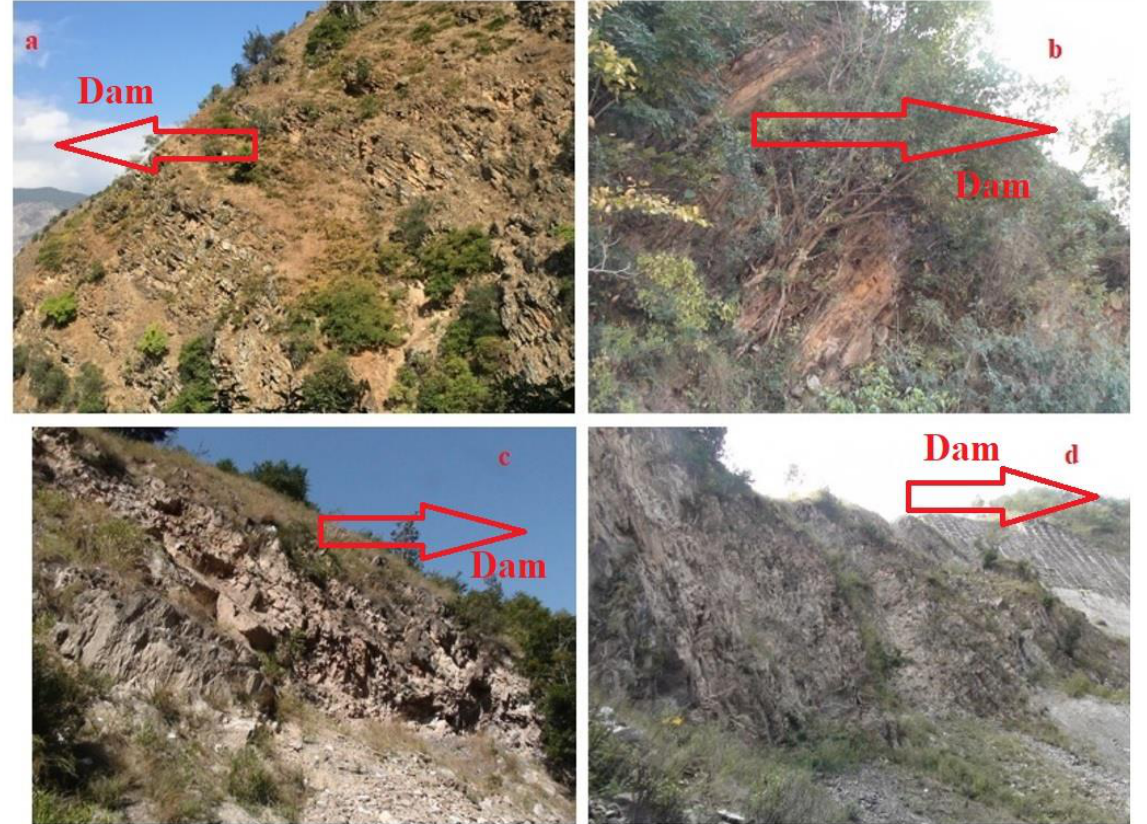
Figure 3. ( a ) The toppling deformation body of the upstream side of the Keli River on the left bank. ( b ) The toppling deformation body of the downstream side of the second gully at the dam on the left bank. ( c ) The toppling deformation body of the upstream side of the Tiemenka River on the right bank. ( d ) The toppling deformation body of the downstream side of the Tiemenka River on the right